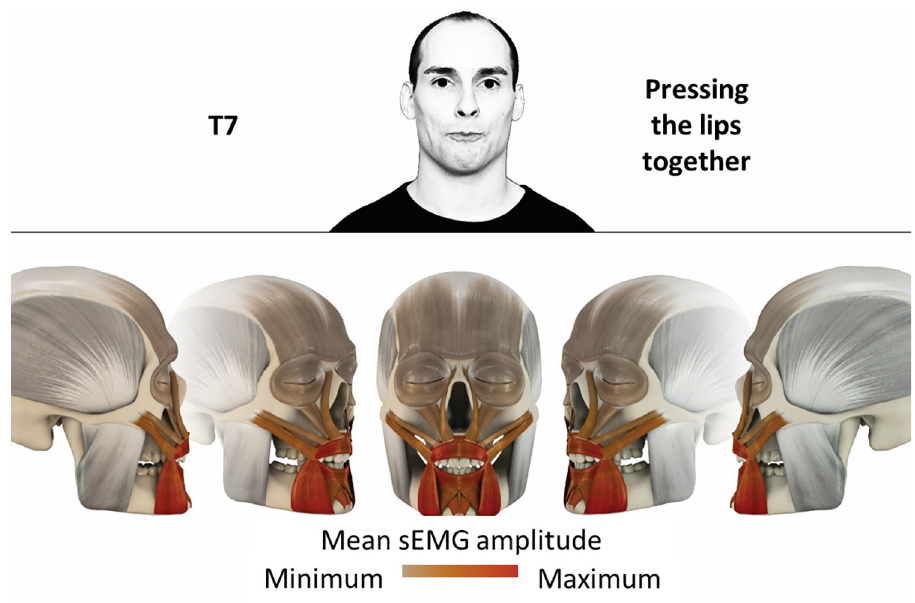
Fig 8. Color-coded facial muscle activation pattern of task T7. Pressing lips together.